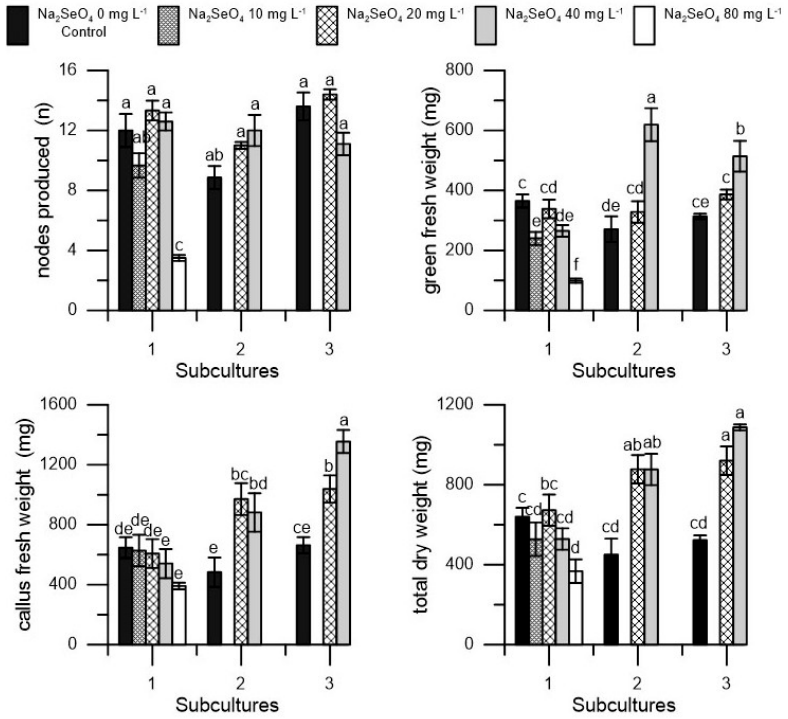
Figure 1. Nodes (n), green fresh weight (mg), callus fresh weight (mg), and total dry weight (mg) in ‘San Felice’ cv. in three different subcultures (1, 2, and 3) at five dosages of Na 2 SeO 4 (0, 10, 20, 40, and 80 mg L − 1 ) during the first subculture and at three dosages of Na 2 SeO 4 (0, 20, and 40 mg L − 1 ) during the second and third subculture. Each value represents the average of three replicates ± SEM. Mean values followed by different letters were significantly different ( p < 0.05).